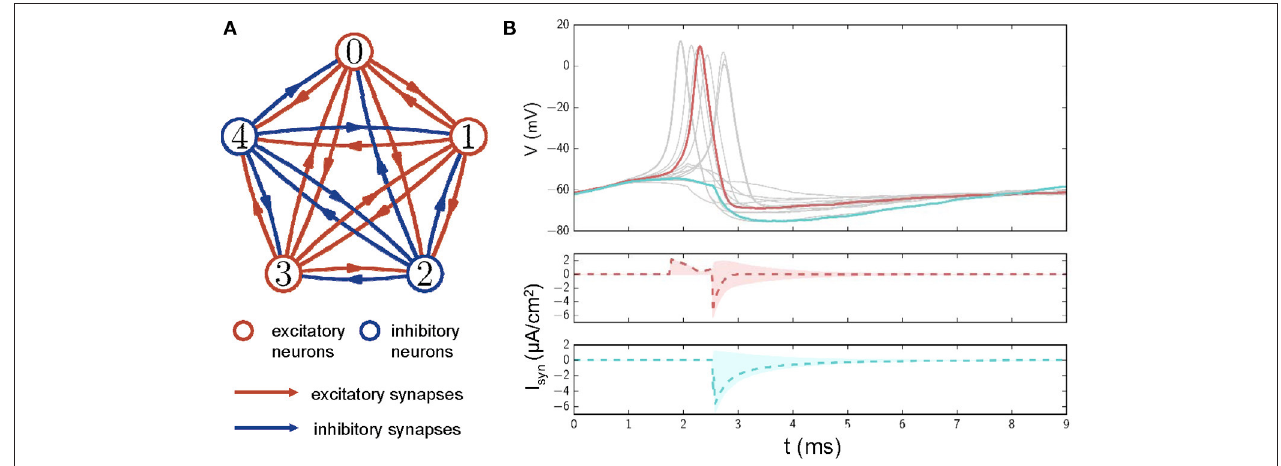
FIGURE 1 | (A) A diagram of a neuronal network with excitatory and inhibitory synaptic couplings. Red circles represent excitatory neurons, and blue circles represent inhibitory neurons. Lines with arrows mark the connections and directions of synapses. Red: excitatory connections; Blue: inhibitory connections. (B) Top: Examples of membrane potential traces for neurons in the network after stimuli are applied at 0 ms . To have a better view, only membrane potential traces of 15 neurons are displayed. Middle: synaptic currents for the neuron whose membrane potential is shown in red. Dashed lines represent the averaged synaptic currents from the other neurons. The red shadow represents the range covered by synaptic currents from other neurons. Bottom: as in the middle plot, these traces represent a neuronal membrane potential in cyan. 1 I 6.05 µ A / cm 2 and D 0.1 in these simulations. = =